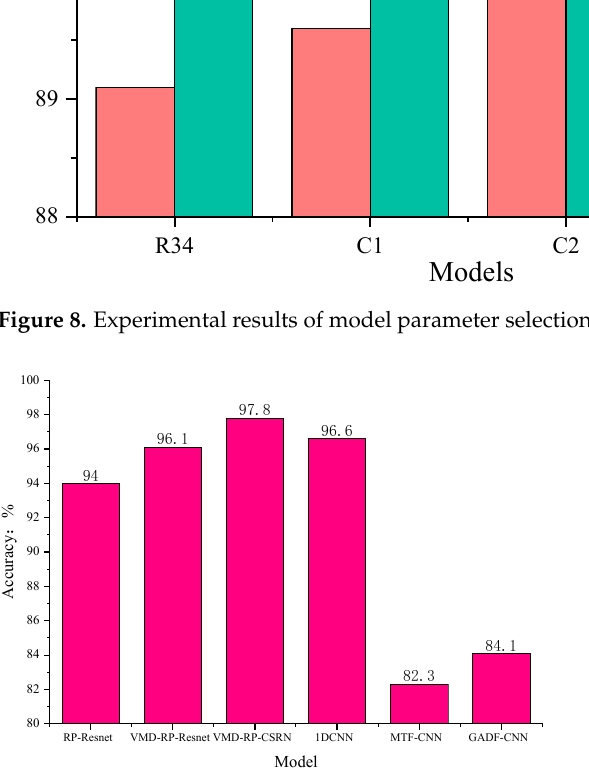
Figure 9. Diagnostic performance experiments with the VMD–RP–CSRN model.